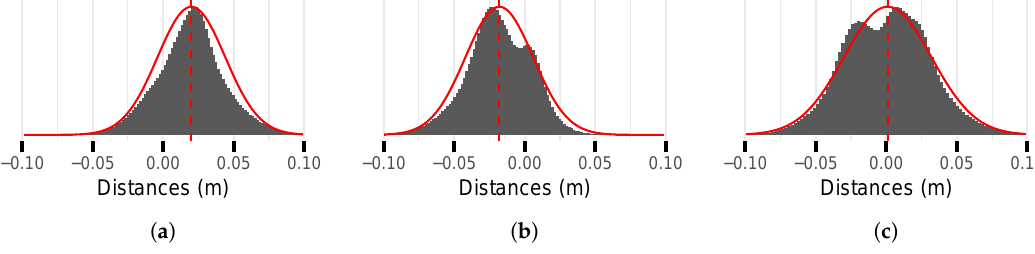
Figure 17. Statistical distributions of the distance between the laser mesh and the sonar point cloud for ( a ) the right and ( b ) left lock walls, as well as ( c ) for the total of the two walls. The Gaussian models fitted to these distributions are represented by the red curves.